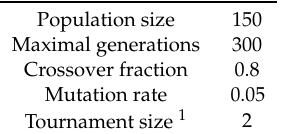
Table A1. Parameters of the optimization algorithm.